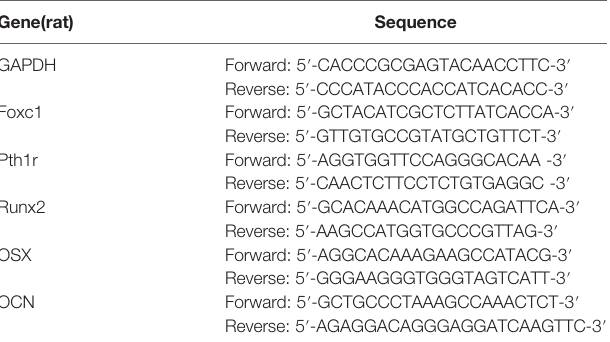
TABLE 5 | Real-Time PCR primer sequences for target genes (rBMSCs). Gene(rat) Sequence